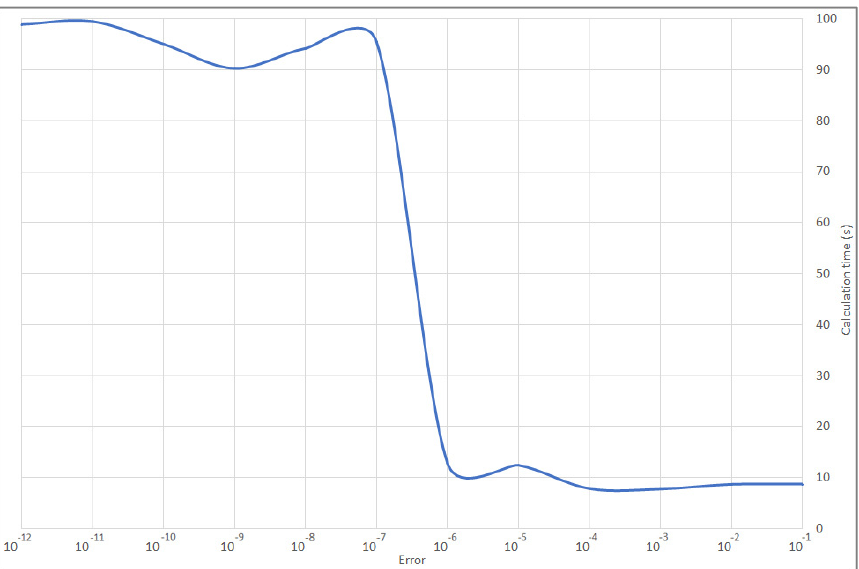
Figure 9. Dependence of the calculation time on error.